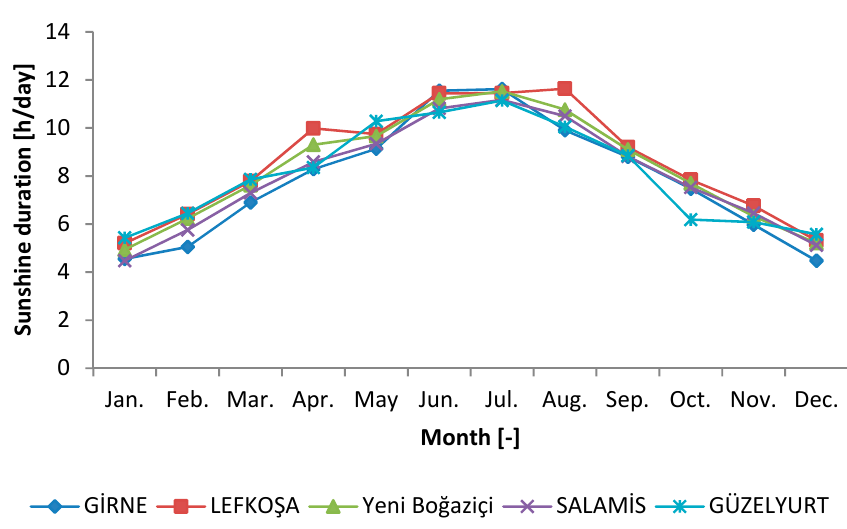
Figure 7. Mean monthly sunshine duration for all chosen regions.